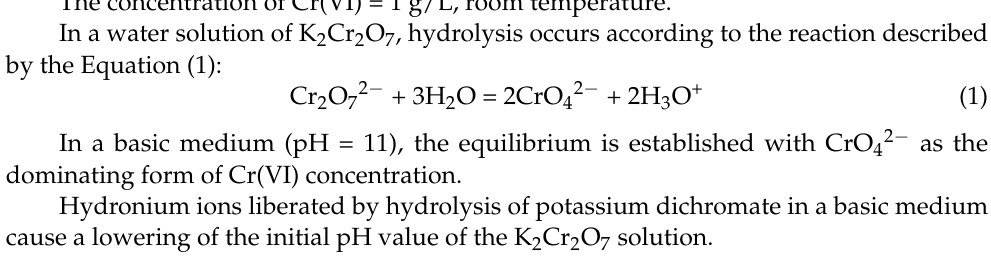
Figure 4. Changes of pH for the water solution of K 2 Cr 2 O 7 as a function of time. The concentration of Cr(VI) = 1 g/L, room temperature.